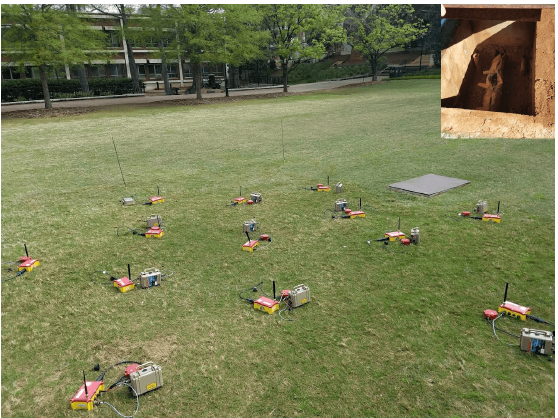
Figure 8. Deployment location at the University of Georgia (UGA) campus. Upper right: A visual of the pipeline that is around ∼ 1.5 and 1.8 m under surface.